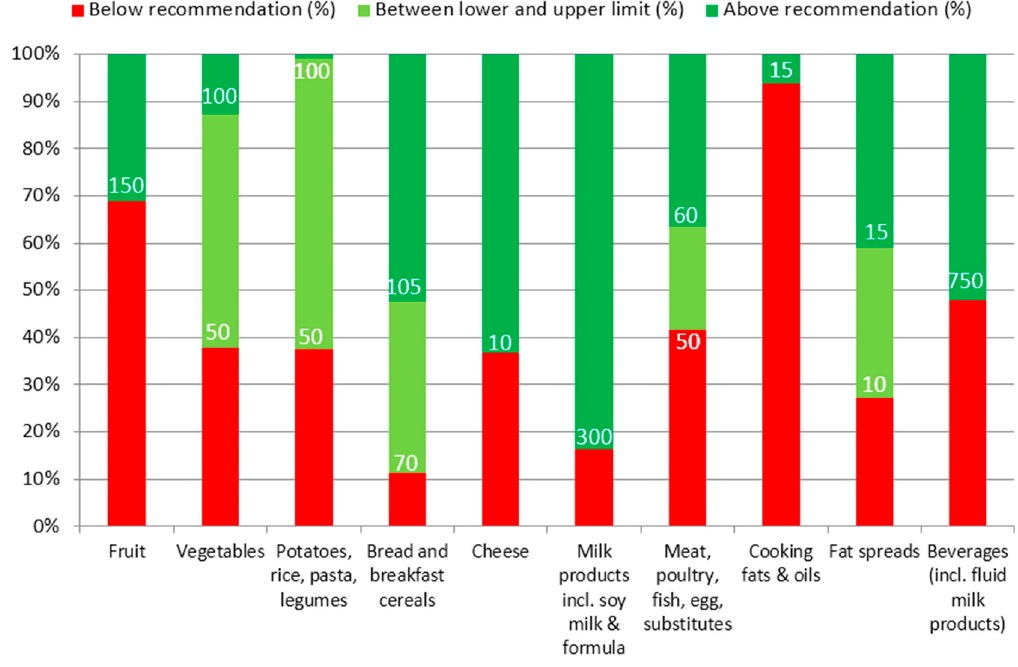
Figure 1. Percentage of children from 1 year old with a daily consumption (g) below, above or in within the range of the recommendation.